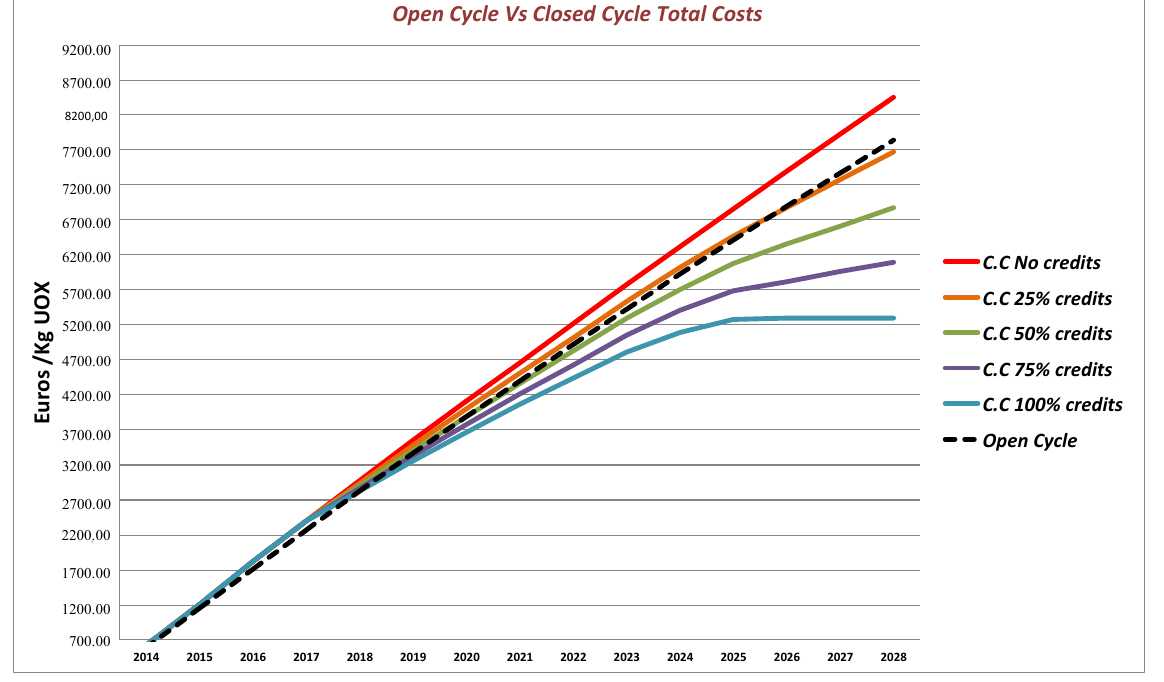
Figure 6. Comparative analysis of total cost for each alternative for the whole period of study .